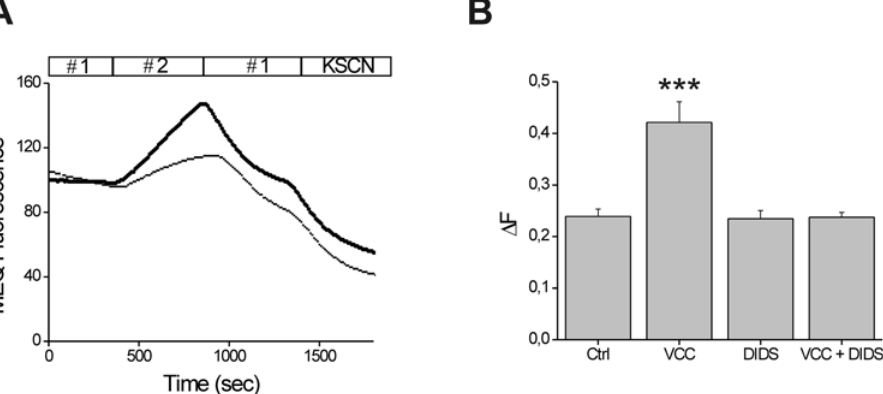
Figure 2. Chloride efflux induced by VCC in Caco-2 cells. A) Caco-2 cells, loaded with MEQ were incubated with (thick line) or without (thin line) 500 pM VCC. Fluorescence was estimated upon sequential buffer substitution with Cl 2 - containing medium ( # 1) followed by Cl 2 -free medium ( # 2). Substitution of solution ( # 1) by solution ( # 2) led to an increase of MEQ fluorescence (dequenching). Subsequent substitution by solution # 1 induced an influx of Cl 2 ions, thus quenching MEQ fluorescence. Values are normalized with respect to the base line. B) Effect of 100 m M DIDS on VCC-induced chloride efflux. D F has been calculated as reported in the Material and Methods section. Each histogram represents an average of thirteen independent experiments with a recording of 2–3 cells in each assay. Significance, determined by Student’s t test, was compared to non- treated cells (Ctrl); ***, p , 0.001.